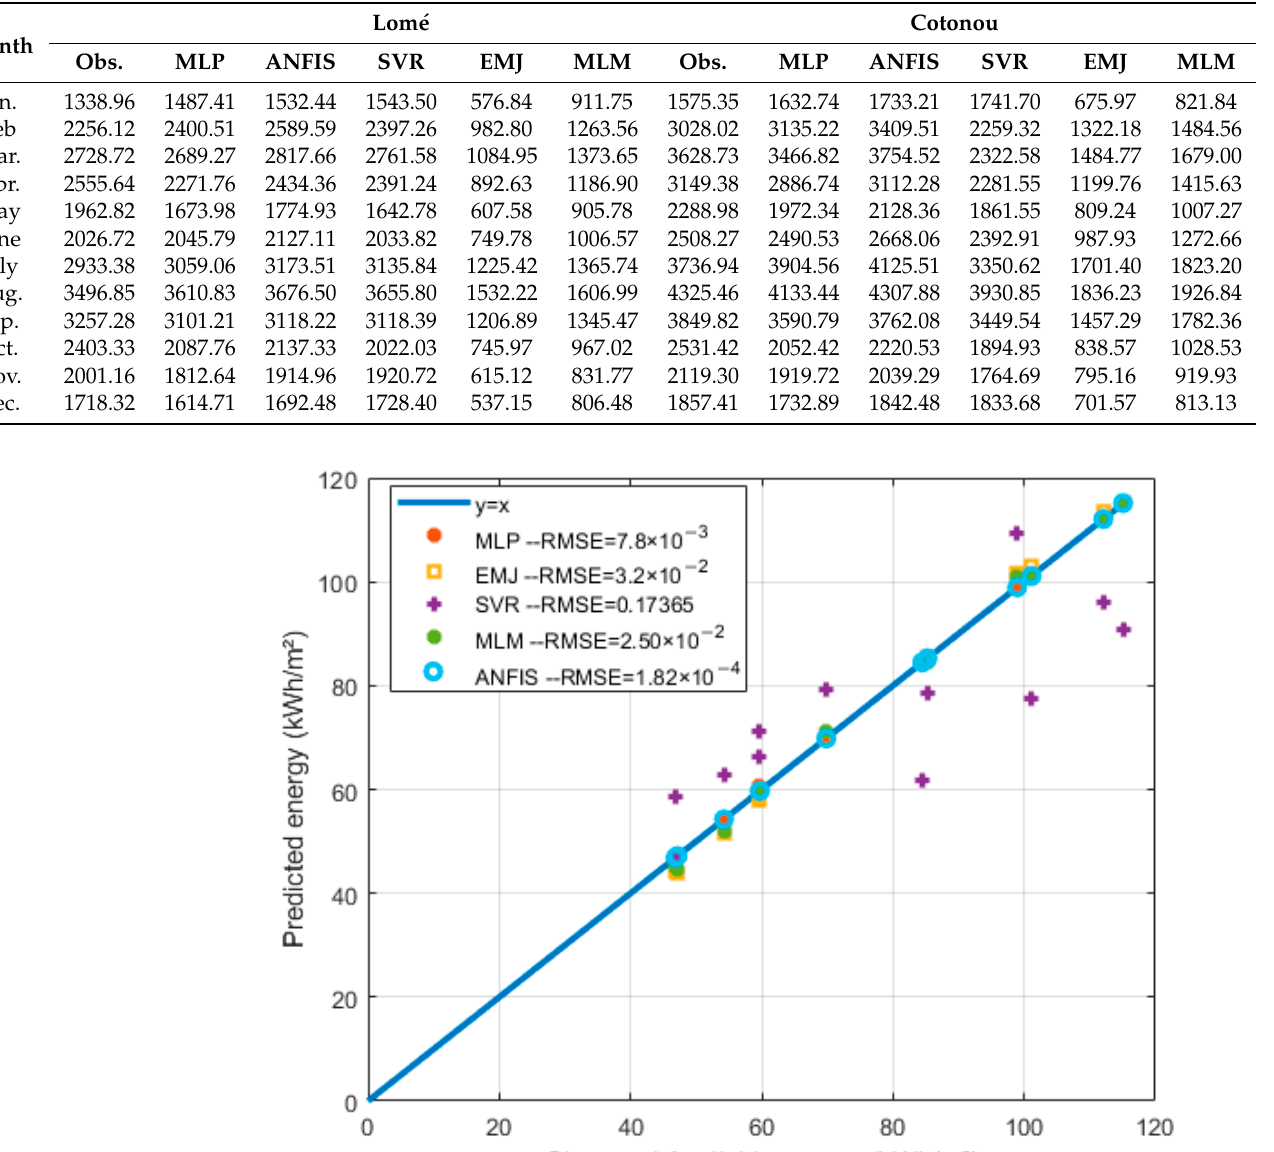
Table 12. Recoverable energy estimation (kWh).